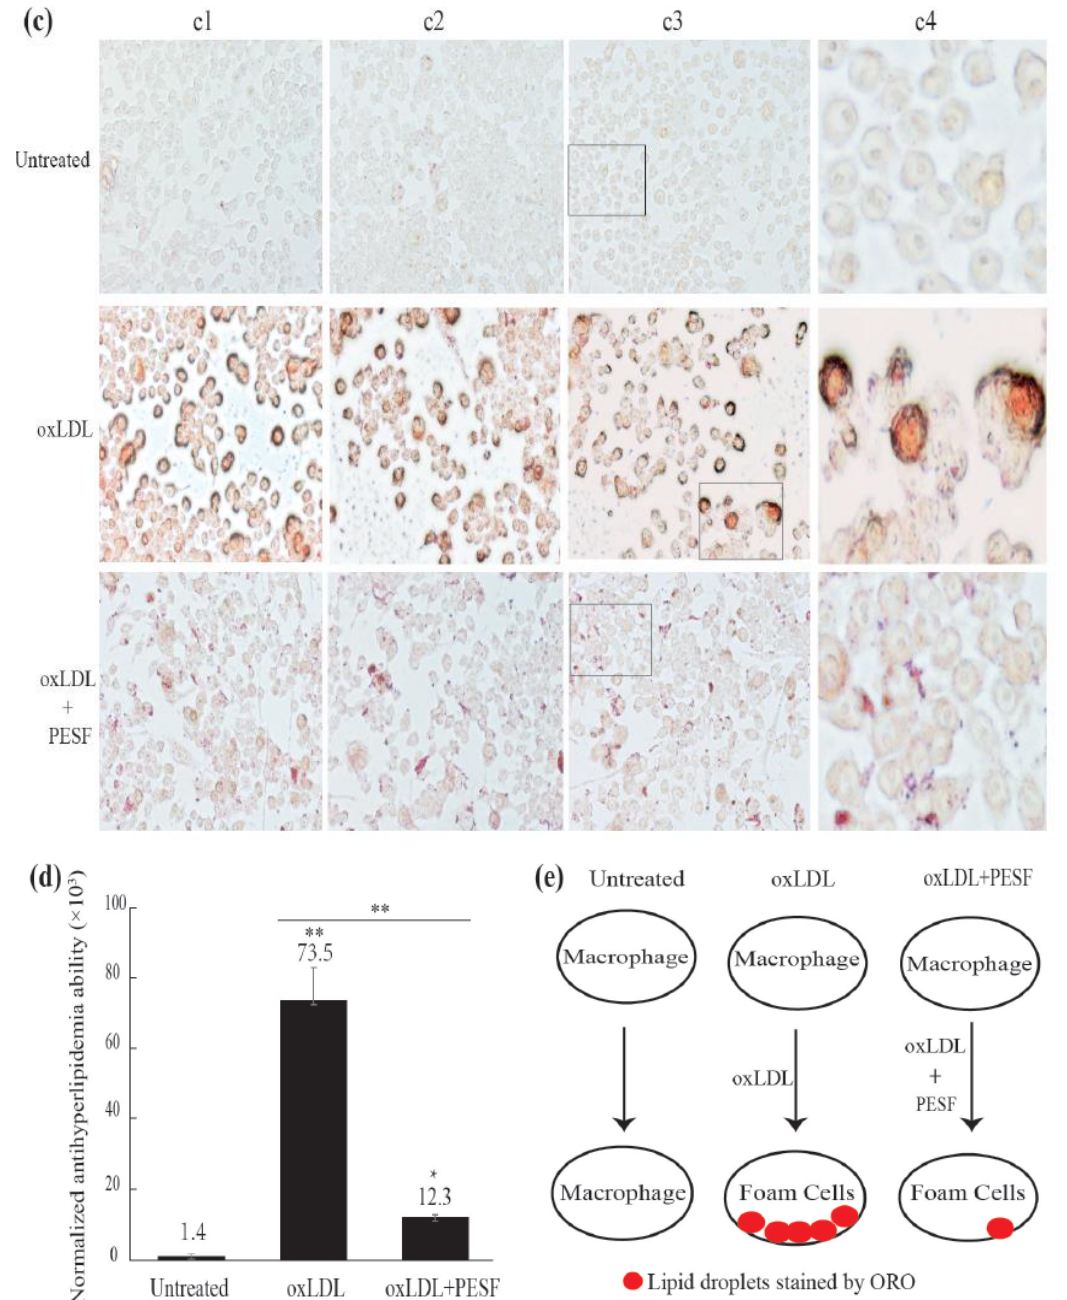
Figure 2. The P. eryngii polysaccharide from solid-state fermentation (PESF) was able to reduce accumulation induced by oxidized low density lipoprotein (oxLDL) in murine macrophages (RAW264.7 cells) with no detectable toxicity on cell viability. ( a ) Microphotographs of cells co-cultured with different concentrations of PESF (0, 100, 200, and 300 µg/mL) for 24 h by a phase contrast microscope. ( b ) Quantification data of the MTT assay showed the viability of cells affected by different concentrations of PESF. ( c ) Microphotographs of cells in the the oxLDL group, the oxLDL + PESF group and the normal group, showed intracellular red lipid droplets stained by oil red O (ORO) (a1, a2, a3). The photographs a4 were amplified with the box part of a3. ( d ) The quantification data of stainable lipid content correlated to microphotographs ( c ). ( e ) Overview of the experiment in murine macrophage-derived foam cells. The macrophages are induced by oxLDL to form foam cells, resulting in the excessive accumulation of red lipid droplets stained by ORO inside the cells of the oxLDL group. PESF inhibited lipid accumulation in the formation of foam cells in the PESF group, using normal macrophages as control.